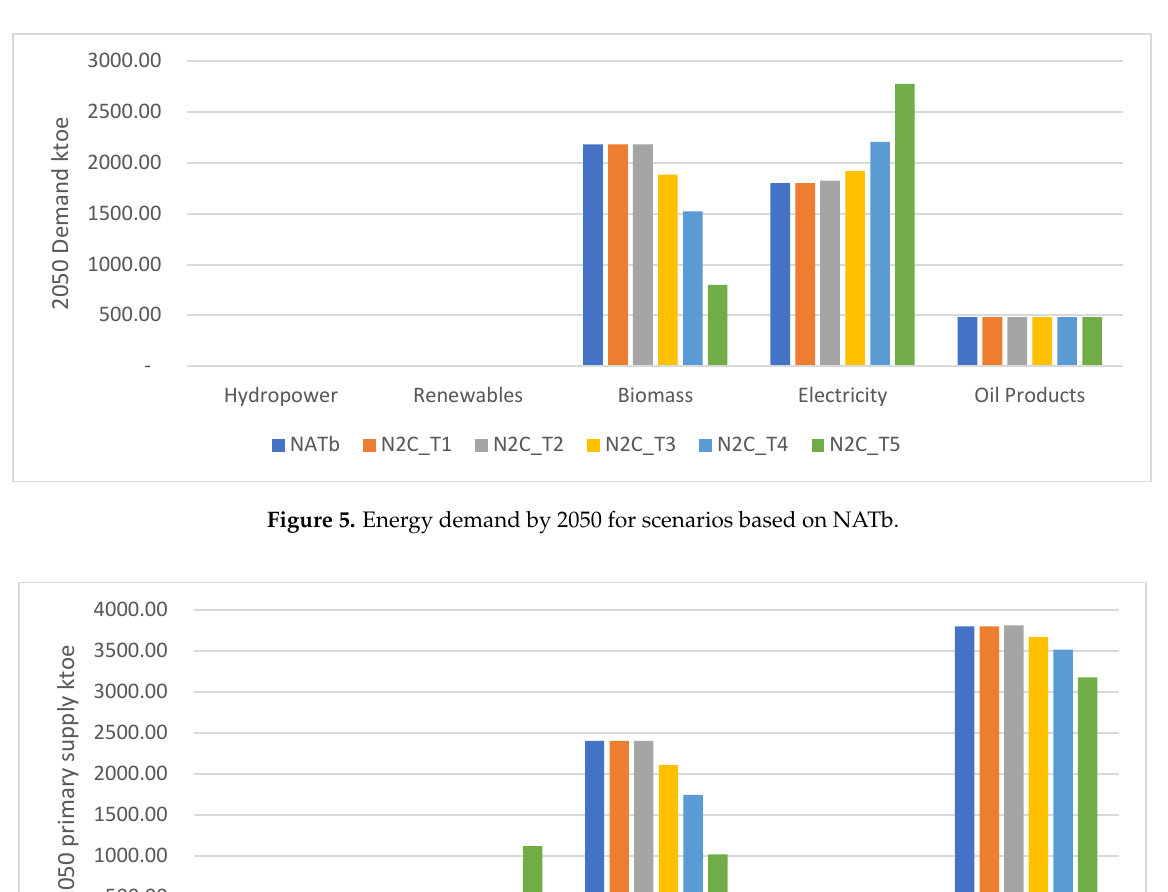
10 of 20 Figure 4. Energy demand by 2050 for scenarios based on NATa.